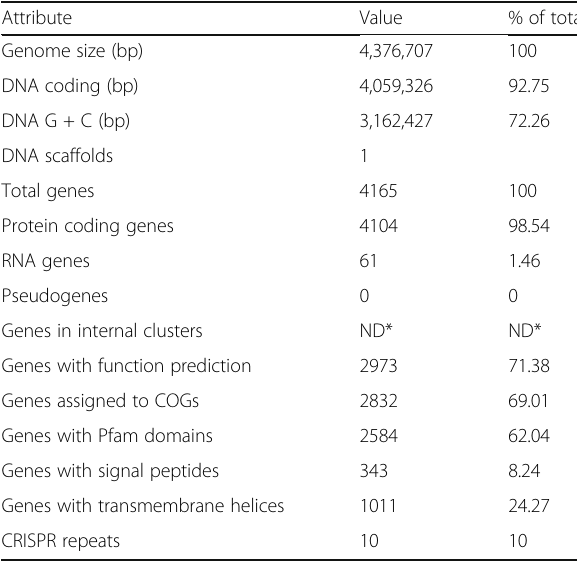
Table 3 Genome statistics